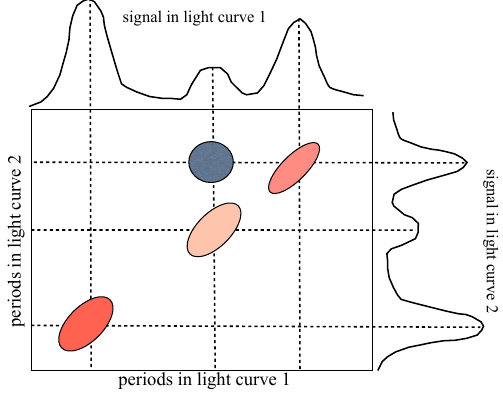
Figure 2. A schematic example of 2D correlation map. Signals present in light curve 1 and 2 are given on the top and right of the map. Cross peaks off diagonal are not detected in AGN light